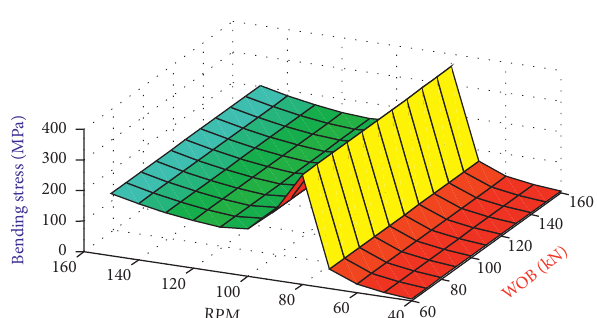
Figure 7: Schematic diagram of RPM-WOB-bending